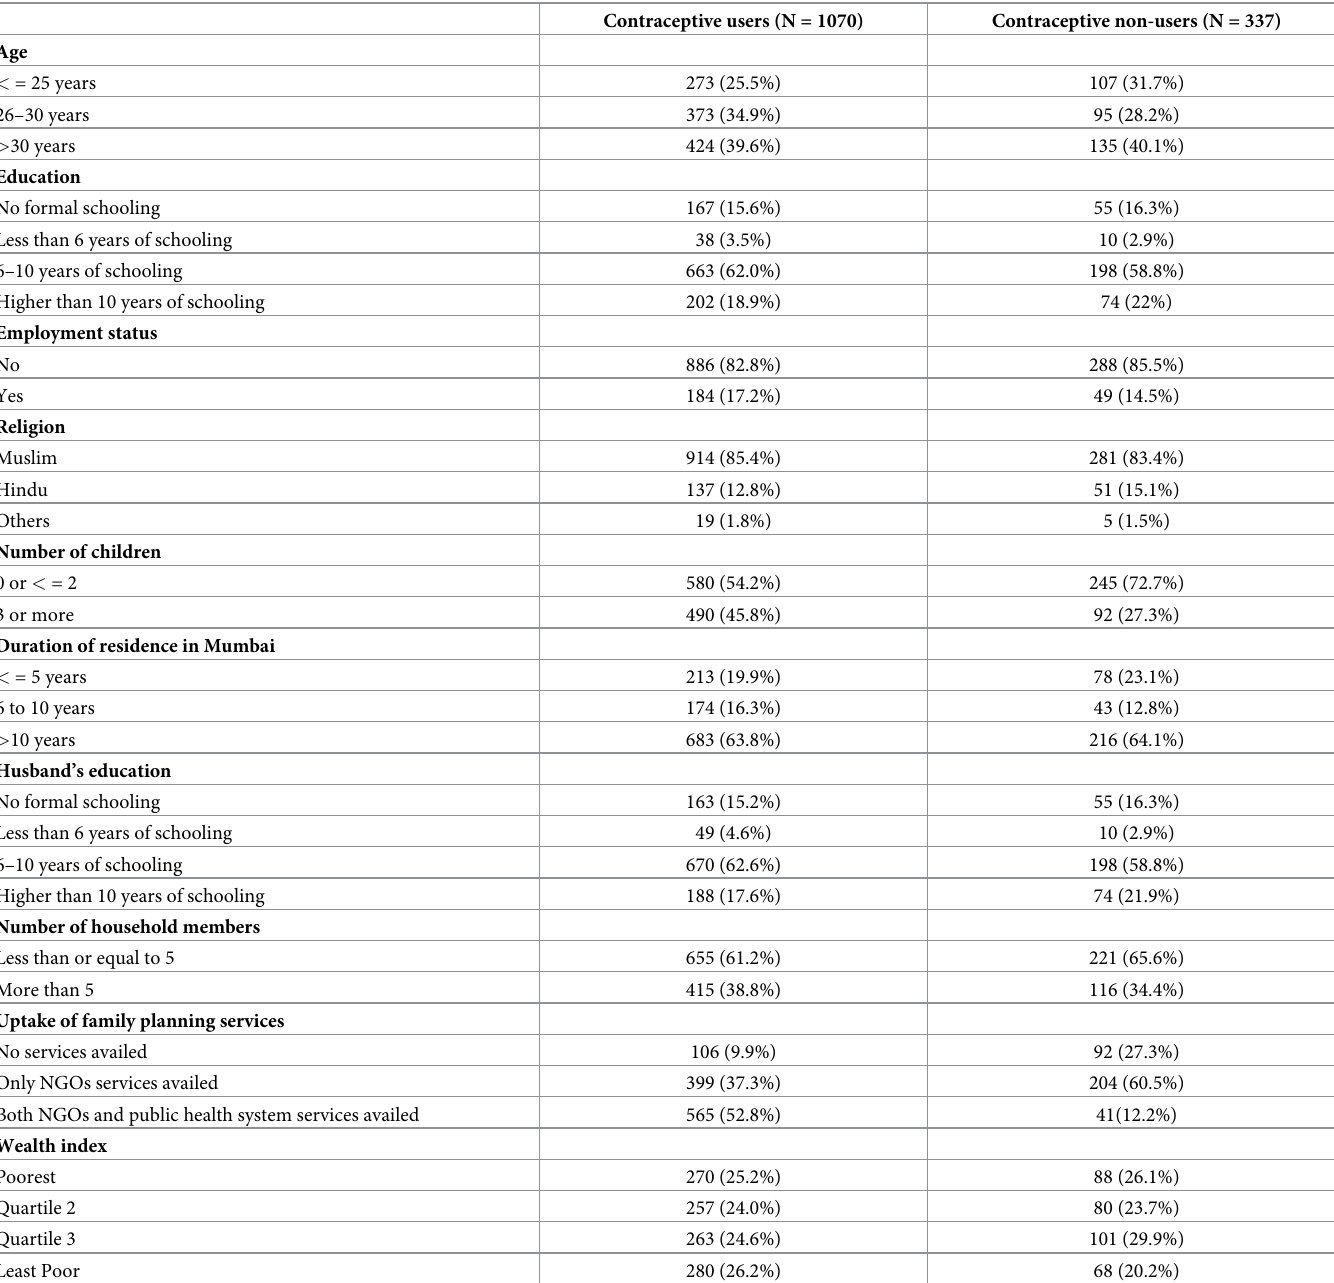
Table 3. Socio-economic and demographic characteristics of married women of reproductive age (15–49 years) in urban informal settlements of Malvani,